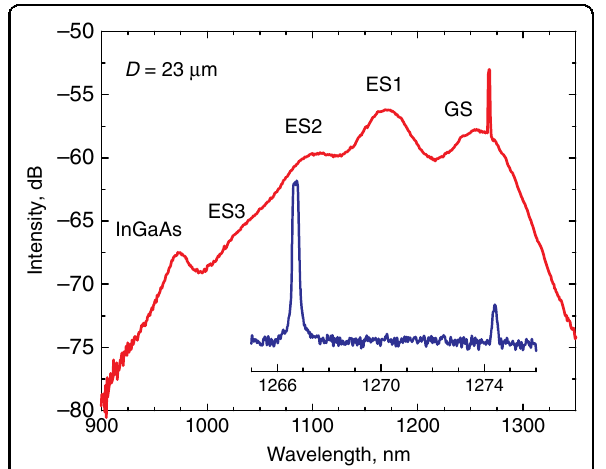
Fig. 7 Emission spectra. Main panel: whole emission spectrum of QD-on-GaAs microdisk. Inset: spectrum taken with a higher resolution